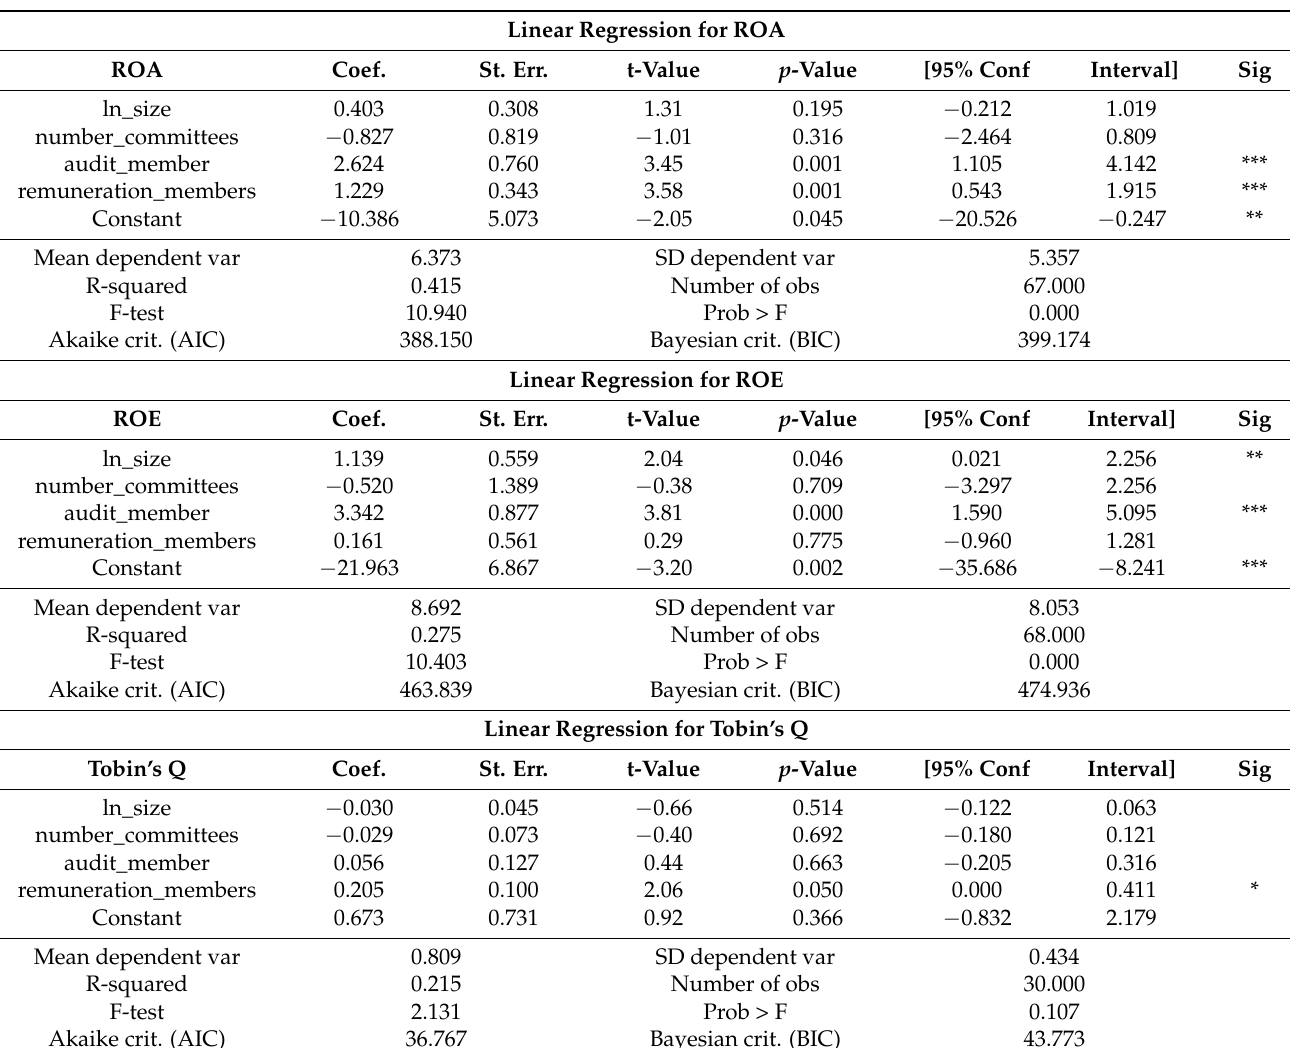
Table 6. OLS regression results with board committees. Linear Regression for